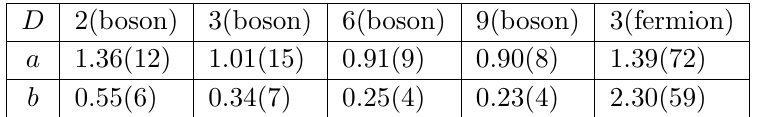
Table 2 . The coe(cid:14)cients in the (cid:12)tting (4.1) for the bosonic model (2.12) at D = 2 ; 3 ; 6 ; 9, and the fermionic model (3.1) at D =